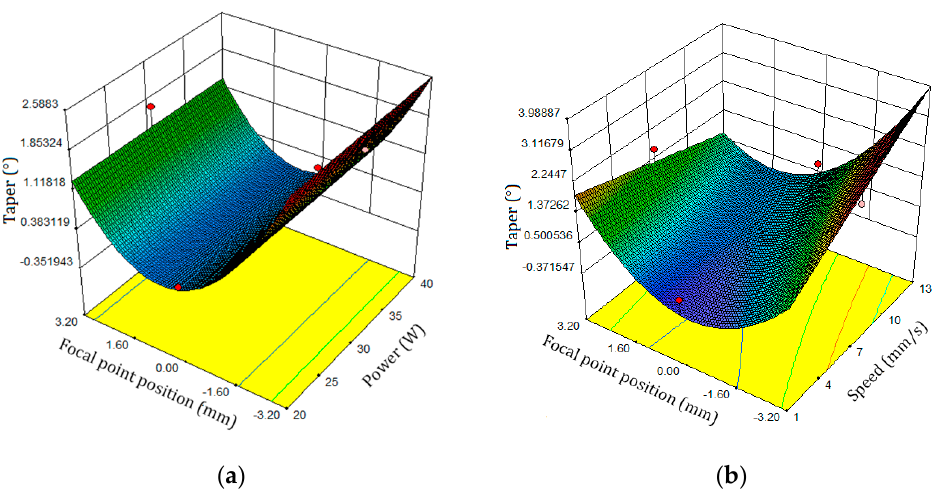
Figure 13. Taper response surface plate: ( a ) FPP and Power, ( b ) FPP and laser cutting speed.